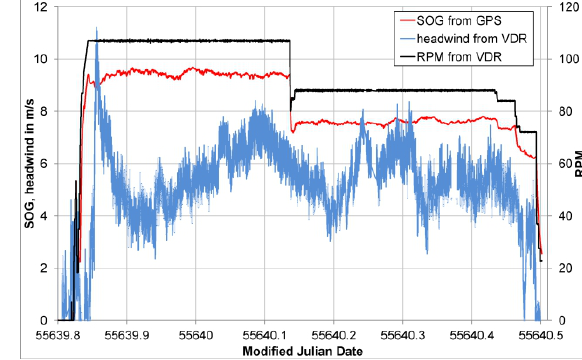
Figure 9. GNSS-derived speed over ground (SOG), headwind and RPM data from ship’s VDR during the